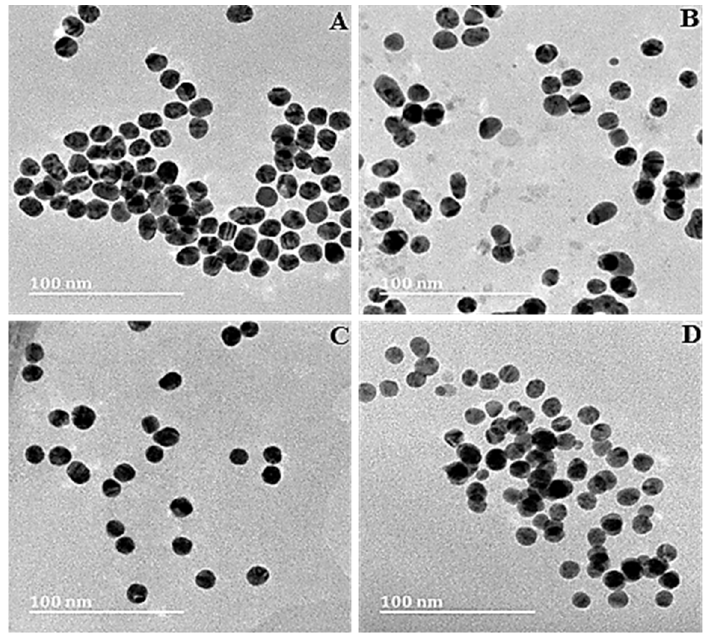
Figure 2. FTIR spectra of ( A ) AuNPs, ( B ) Au-CS, ( C ) Au-CS-His and ( D ) Au-CS-FA-His.